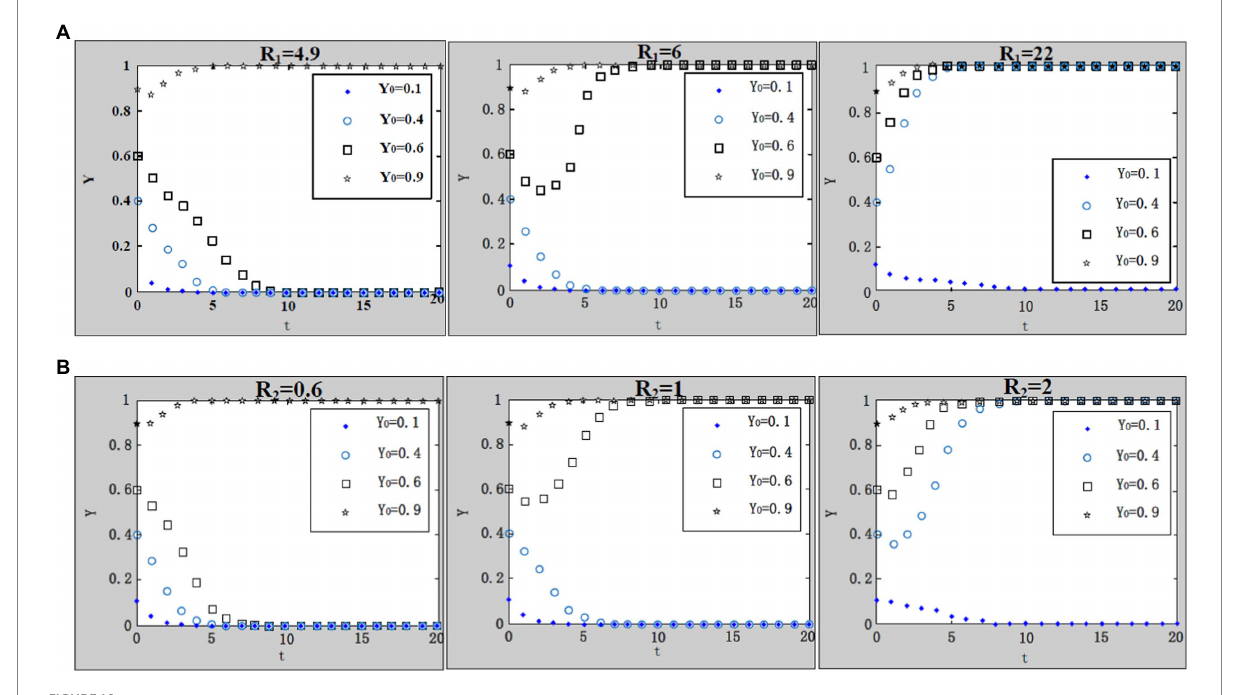
FIGURE 10 (A) Influence of rewards ( 1 R ) from the central government to local governments for strict supervision on the evolution result. (B) Influence of rewards ( 2 R ) from the central government to local governments for strict supervision on the evolution